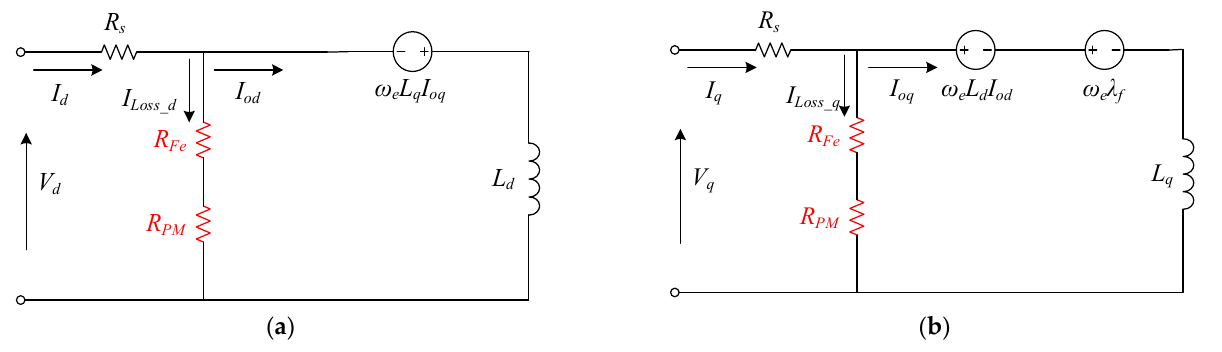
Figure 14. Differential mode ECM of PMSMs with predictable core loss: ( a ) d -axis; ( b ) q -axis [29].